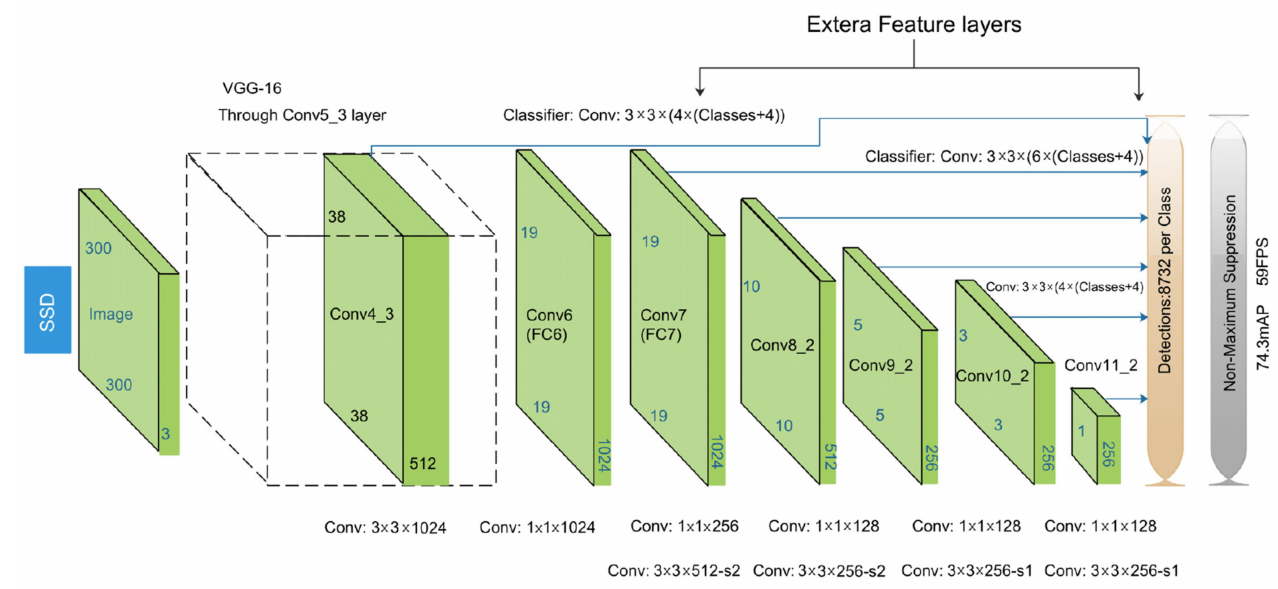
Figure 2. SSD architecture adapted from Liu et al. and Bahaghighat et al.